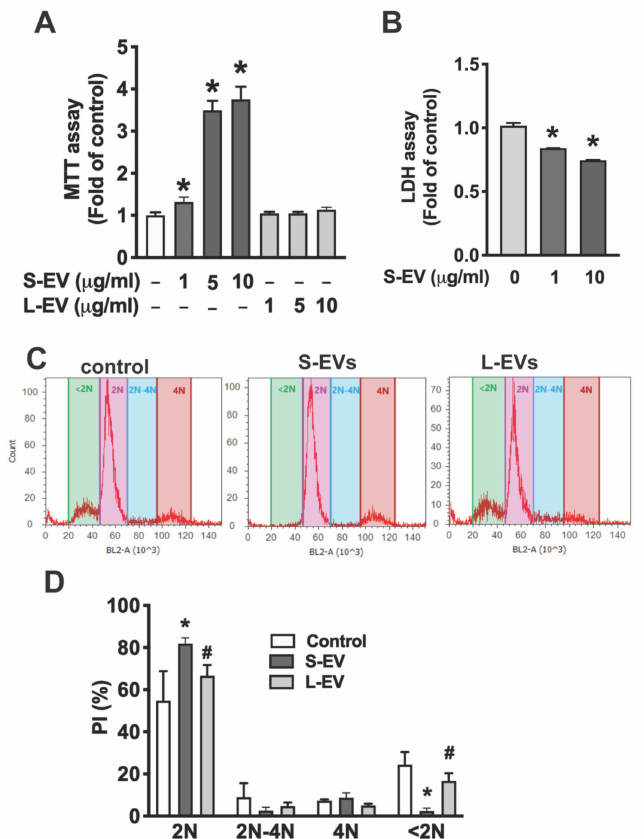
Figure 2. ( A ) Primary microglia were treated with NDEVs purified from rat neuronal cultures for 24 h and cell viability was detected by MTT assay. ( B ) Cell supernatant was collected for LDH assay. Data in A and B are shown as fold of control. ( C ) Flow cytometric analysis of DNA content by PI staining. ( D ) Data are shown as % of cells in G1 stage (2N), DNA synthesis (2N-4N) and mitotic (4N) or apoptotic (<2N). Data are mean values ± SD of three independent experiments.; * p < 0.05 versus control via post test. # p < 0.05 versus S-EV via post